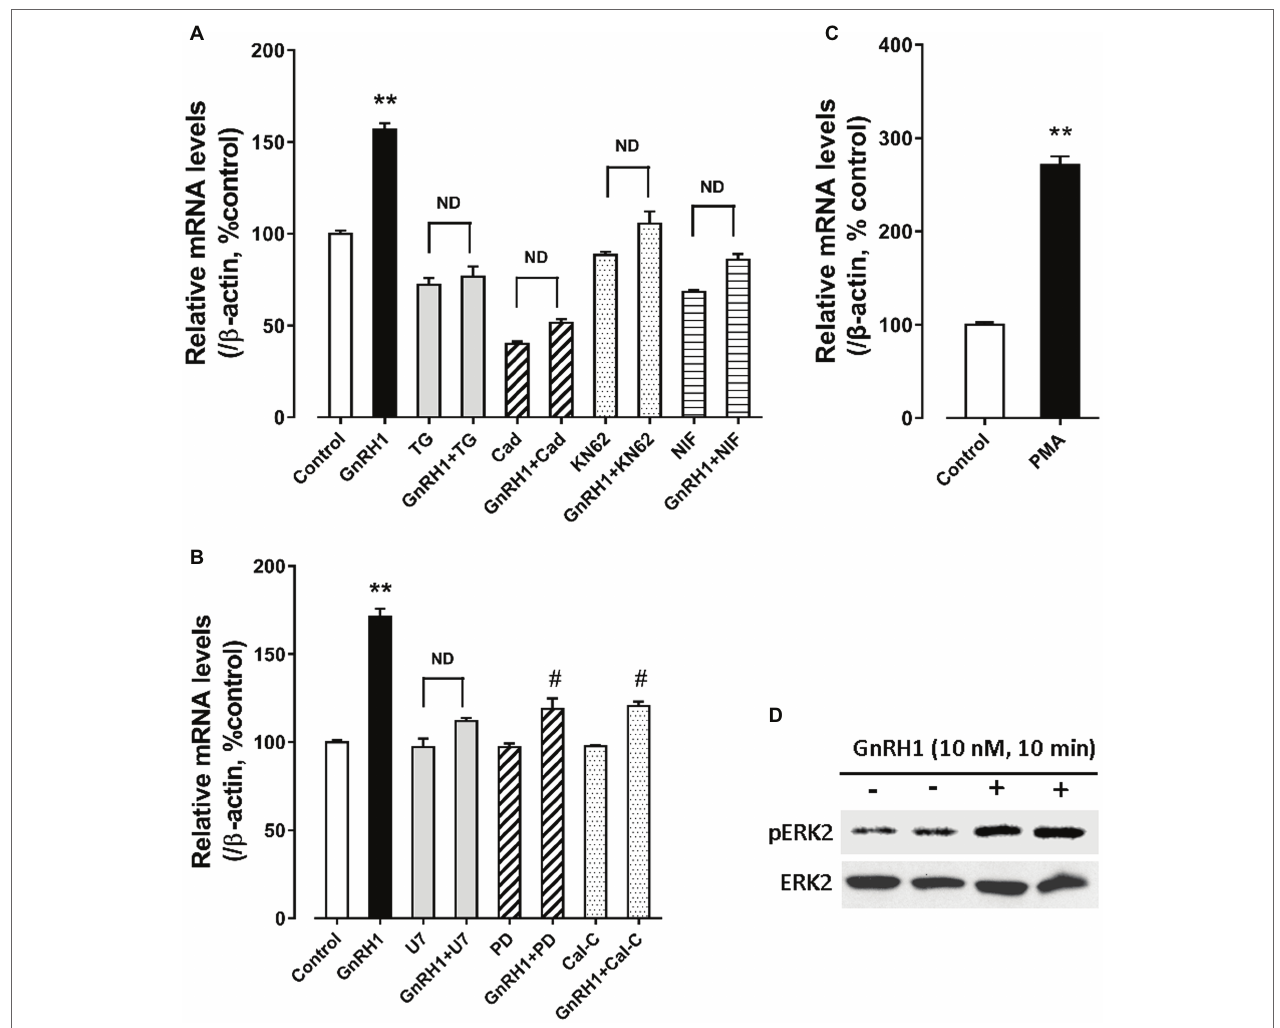
FIGURE 7 | (A) Effect of GnRH1 (10 nM, 24 h) on cocaine- and amphetamine-regulated transcript ( CART ) mRNA expression in cultured chick pituitary cells in the presence or absence of thapsigargin (TG, 100 nM), calmidazolium (Cad, 1 μM), KN62 (5 μM) or nifedipine (NIF, 5 μM), respectively. (B) Effect of GnRH1 (10 nM, 24 h) on CART mRNA expression in cultured chick pituitary cells in the presence or absence of U73122 (U7, 20 μM), PD98059 (PD, 100 μM), or calphostin C (Cal-C, 100 nM), respectively. (C) Effect of PMA (1 μM, 48 h) on CART expression in cultured chick pituitary cells. The cells were treated for 24/48 h before RNA extraction and subjected to quantitative real-time PCR (qPCR) assay of CART mRNA levels. “ND” indicates no statistical difference between the two groups. Each data point represents mean ± SEM of four replicates ( N = 4). ** p < 0.01 vs. control; # p < 0.01 vs. GnRH1 treatment (in the absence of drug). (D) Western blot showed that GnRH1 treatment (10 nM, 10 min) could enhance ERK2 phosphorylation (pERK2) in cultured chick pituitary cells. Total ERK2 in cell lysates was also examined and used as internal controls. Note: only a single band for pERK2 or total ERK2 (42 kDa) was detected in cell lysate, because ERK1 gene is lost in chicken genome (Gerilechaogetu et al., 2009). The representative sets of independent experimental duplicates are shown